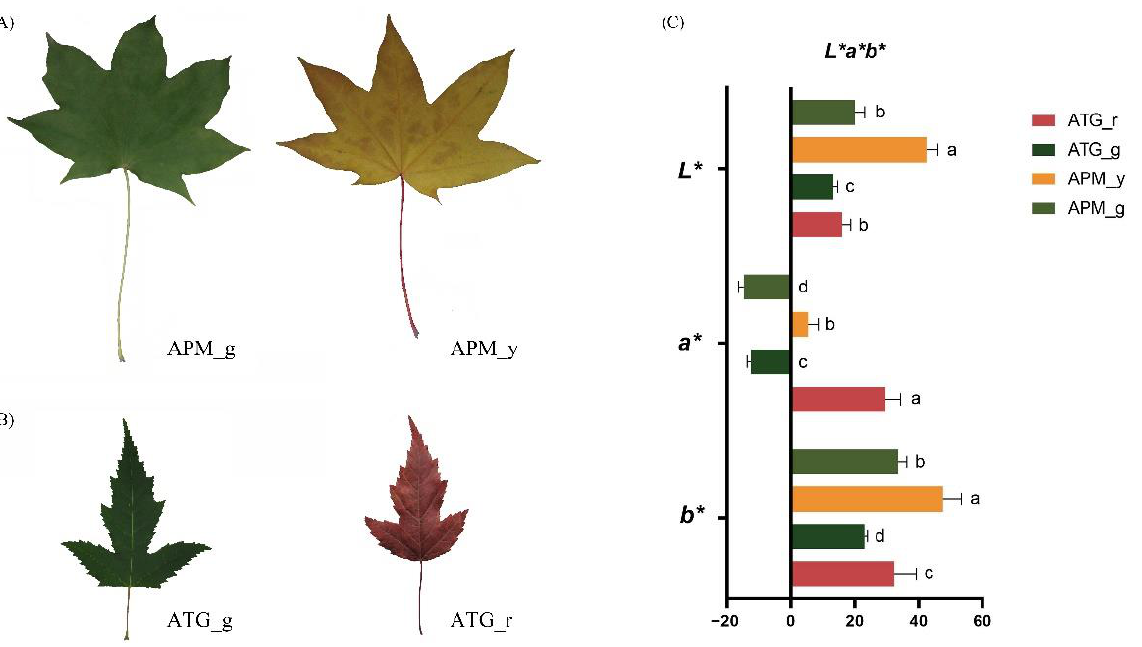
Figure 1. Leaves of two Acer L. species in different seasons and leaf colour parameters: ( A ) APM (green, summer; yellow, autumn); ( B ) ATG (green, summer; red, autumn); ( C ) leaf colour parameters. Different letters indicate significant differences in different tissues ( p < 0.05).